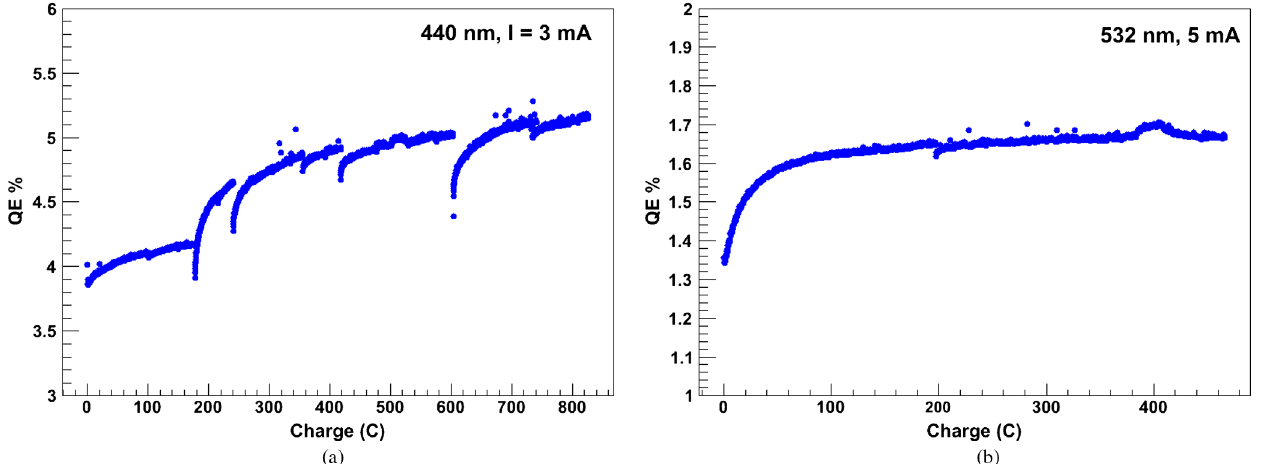
FIG. 9. QE evolution during 200 kV beam delivery from K 2 CsSb photocathode #1: (a) using 440 nm light and (b) 532 nm light. Note QE increasing with extracted charge. The discontinuities are due to static charge buildup on viewers and eventual discharges that move the beam at the Faraday cup.